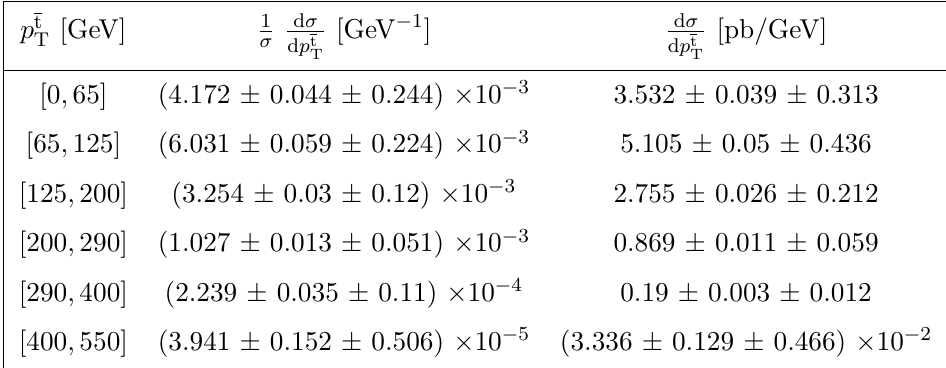
Table 2 . The measured di(cid:11)erential cross section and bin boundaries for each bin of the normalized and absolute measurements of the tt di(cid:11)erential cross section at parton level in the full phase space as a function of p t are tabulated. T